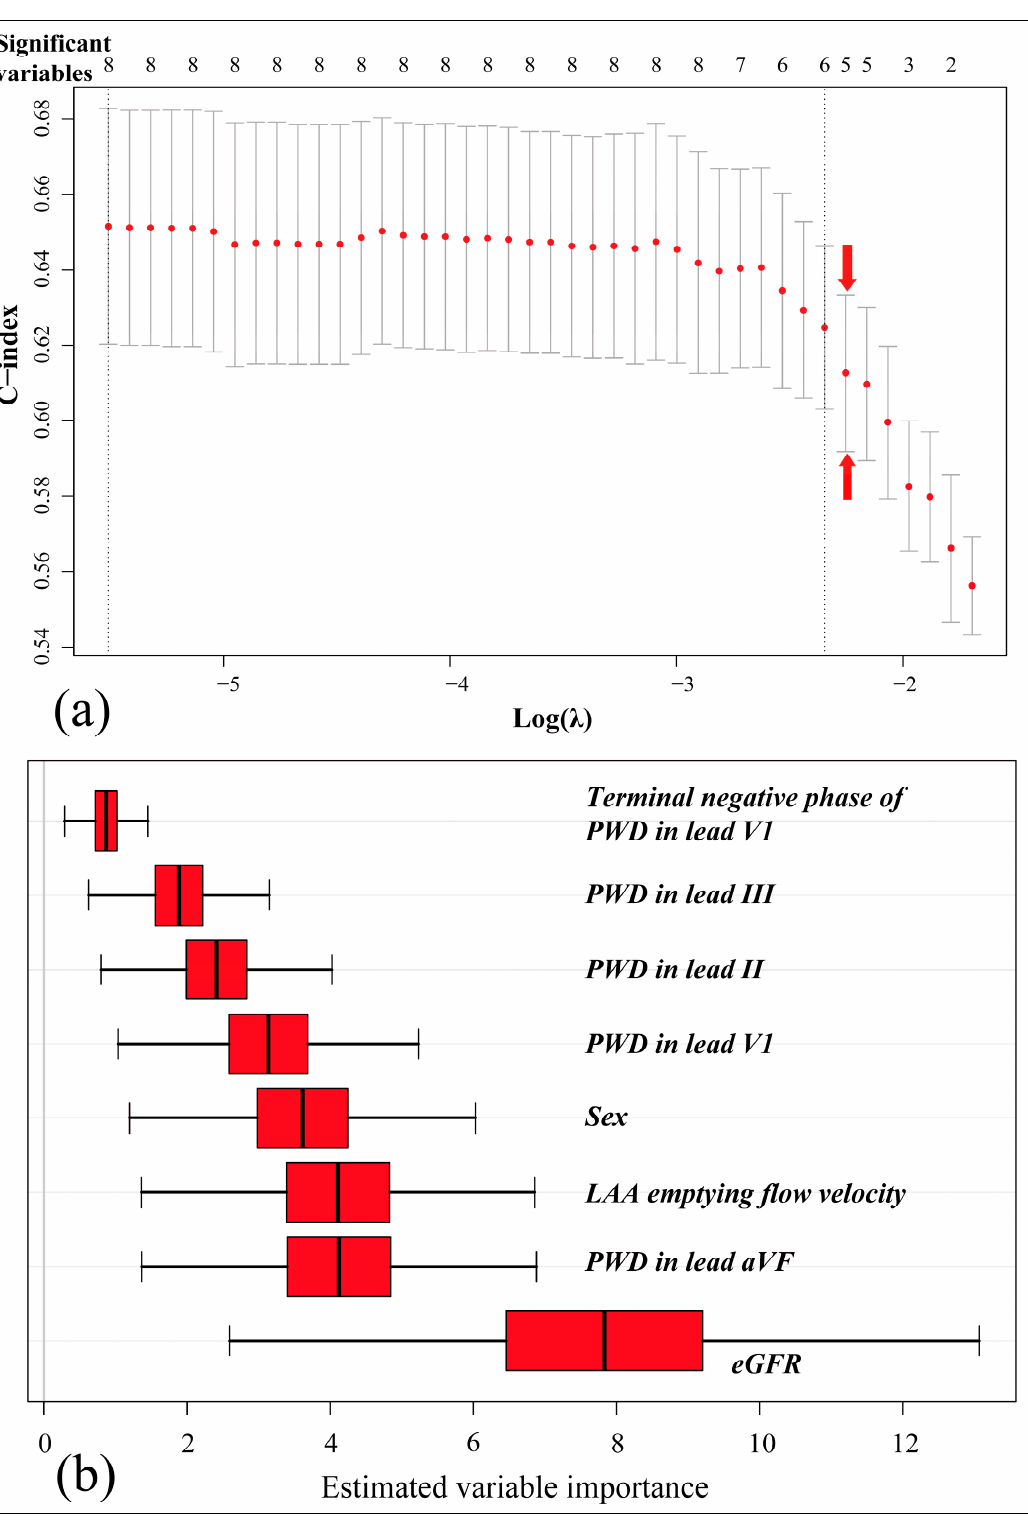
Figure 3. The Lasso-Cox model ( a ) and RSF ( b ) for variable selection. ( a ) depicts how the penalized c-index varied via 5-folded cross-validation, as the L1 norm (lambda value) increased. The logarithmic lambda value of − 2.2535 (the red arrow) was chosen for variable selection. ( b ) gives the estimation of variable importance (with a 95% confidence interval) by RSF via a subsampled method.